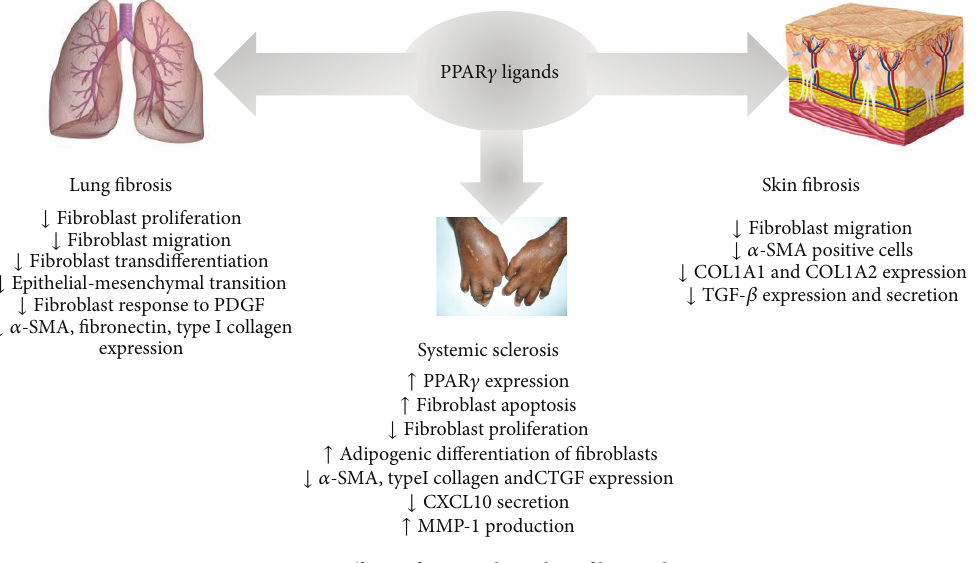
Figure 3: Effects of PPAR 𝛾 ligands in fibrotic